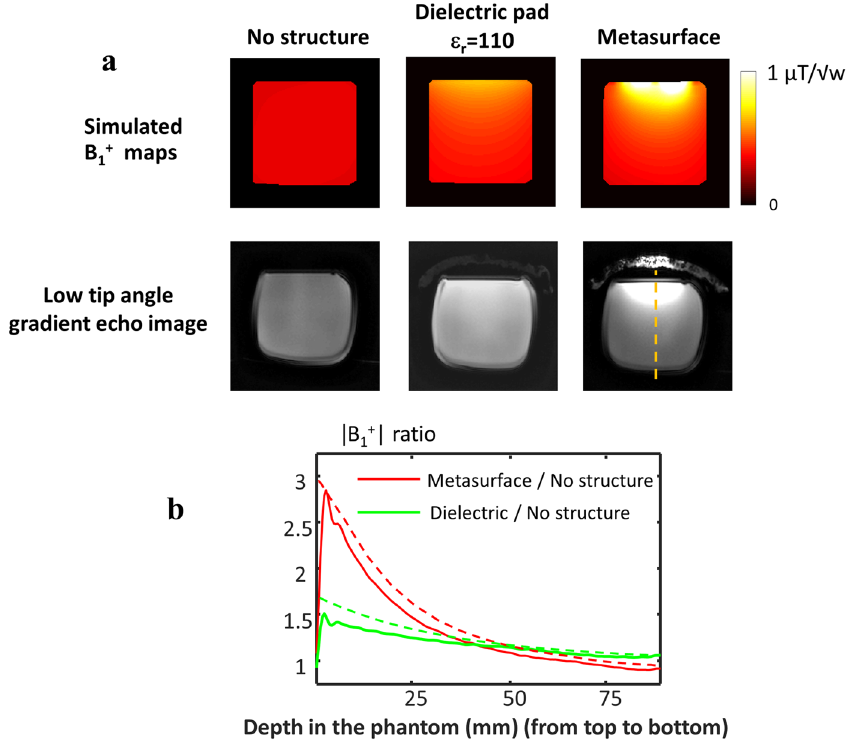
Figure 2. Simulated and measured transmit (B 1 + ) fields in an oil phantom. ( a ) B 1 + maps and the experimentally acquired low flip angle gradient echo images: (left to right) no artificial structure; with dielectric material only; with the metasurface structure. ( b ) Measured (solid line) and simulated (dashed line) B 1 + profile, along the yellow dashed line. Supporting Information S3 includes an illustration of the experimental